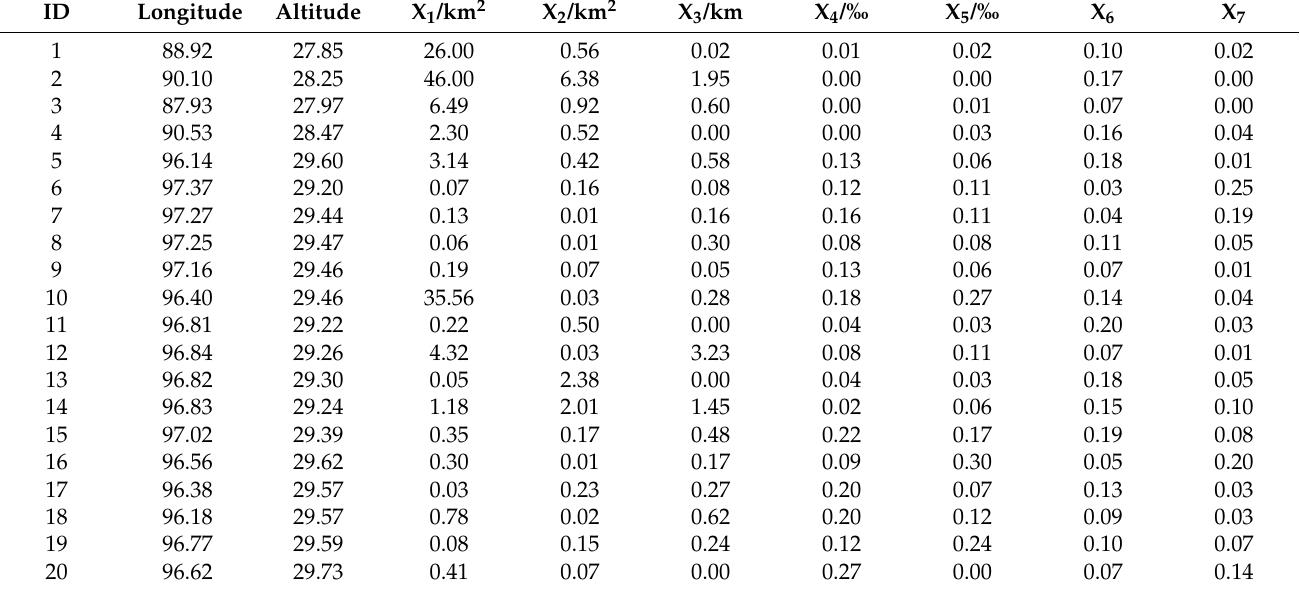
Table 1. Data of glacial lake samples in the study area.